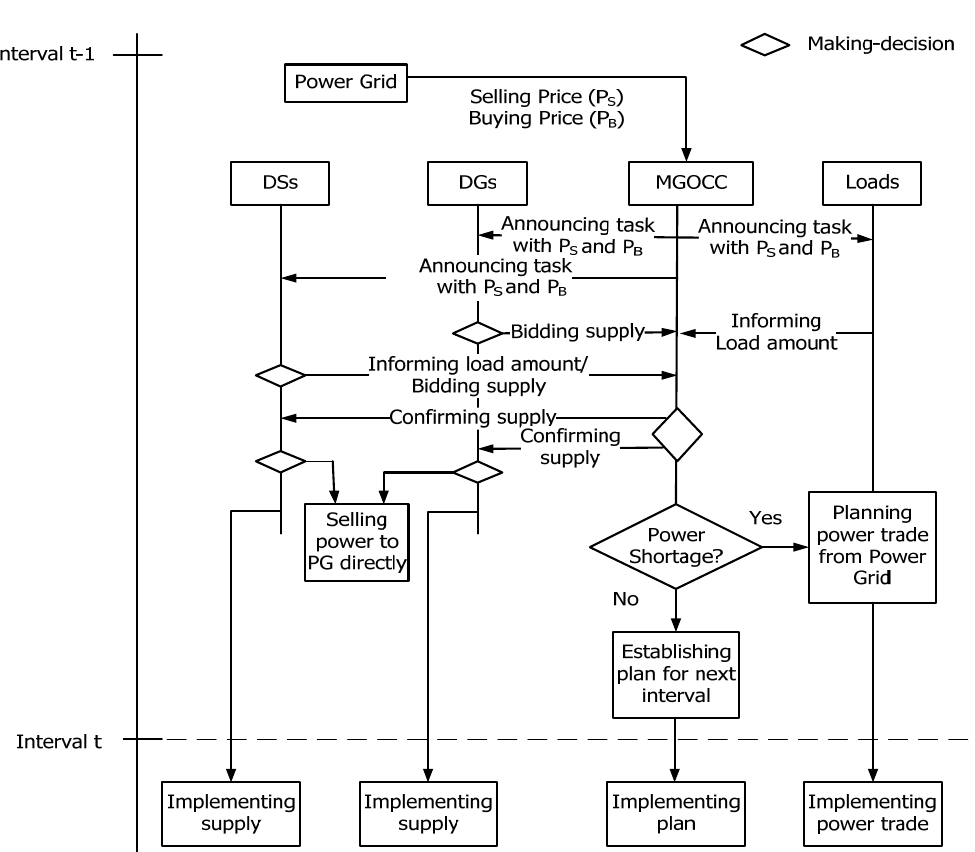
Figure 2. Operation rules for